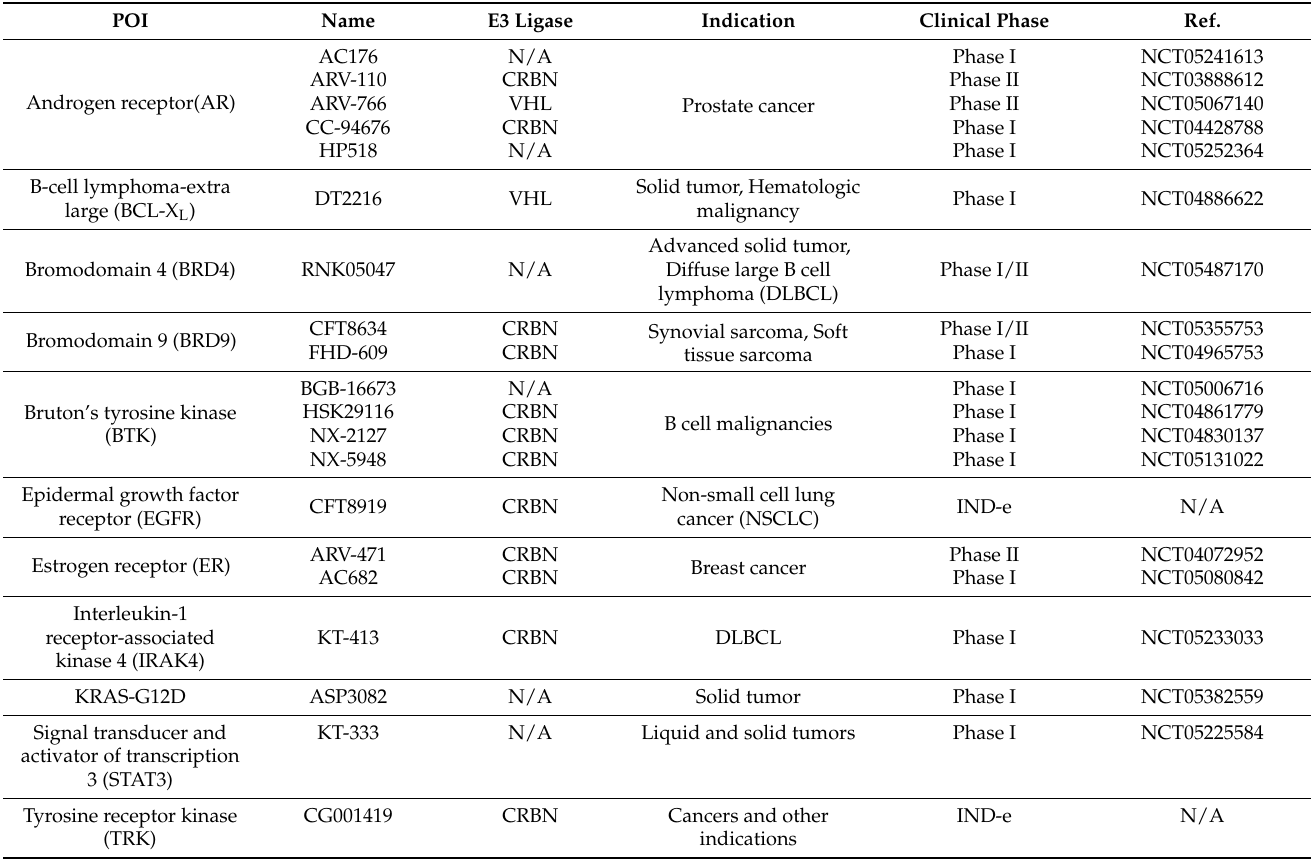
Table 1. PROTACs in clinical trials for anticancer